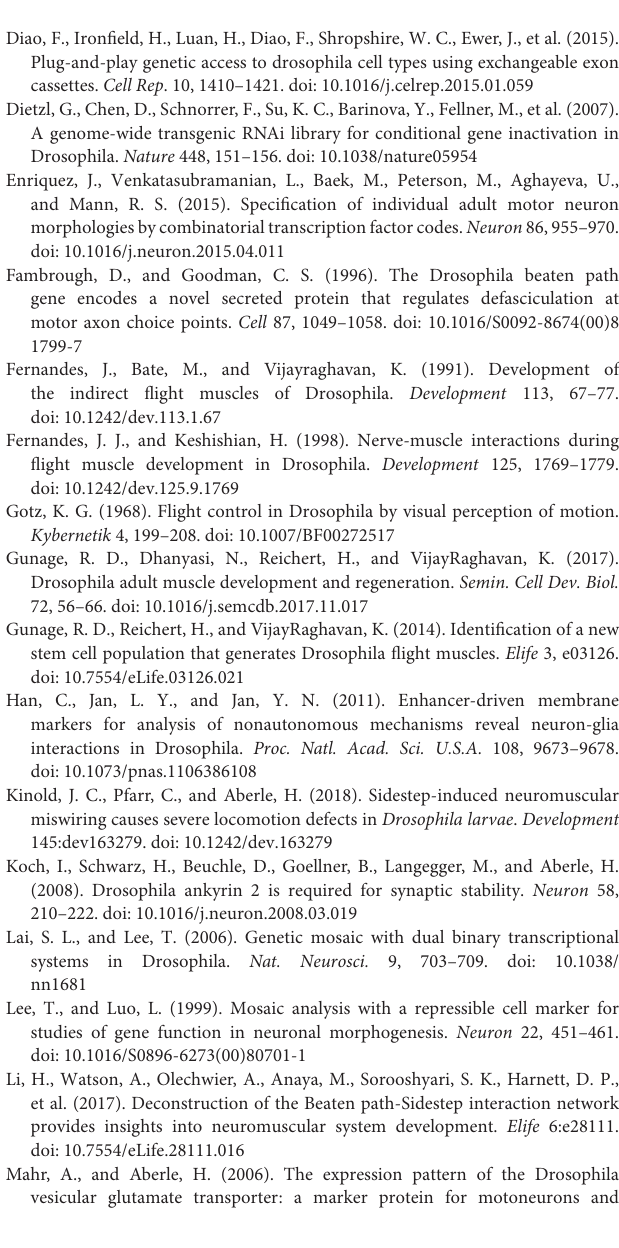
stained with anti-Side antibodies. Expression of a transgenic side RNAi construct in all postmitotic neurons using elav-Gal4 diminishes Side proteins starting at stage 14. Downregulation is increased by co-expression of Dicer. Genotypes: w; + ;ShGFP , yw; + ;SideGFP Mi 00149 , w;UAS-Side-RNAi/ + ;elav-Gal4/ + , w;UAS-Side-RNAi/ + ;elav-Gal4/UAS-Dicer. Scale bars: B–C25 µ m, D–E 200 µ m, H–J 20 µ m. Supplementary Movie 1 | Miswiring alters locomotion patterns. Flies walking freely over glass slides recorded from ventral views using a high-speed video camera (frame rate of 125 fps). While ShGFP control flies use an alternating tripod gait, side mutants display an aberrant gait, including difficulties in leg coordination, spatial positioning, and chronology. Flies overexpressing Side in muscles show predominantly tripod-like patterns but occasionally limp with their metathoracic legs. Genotypes in all movies: w; + ;ShGFP, w; + ;side C 137 , ShGFP/side I 1563 , ShGFP, w; + ;Mef2-Gal4, ShGFP/UAS-Side 29 A .